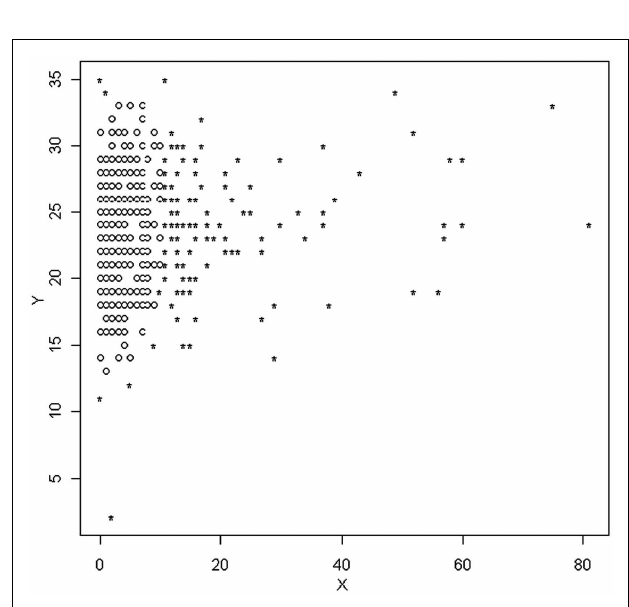
FIGURE 1 | Scatterplot of observations identified as outliers based on the MVE method.